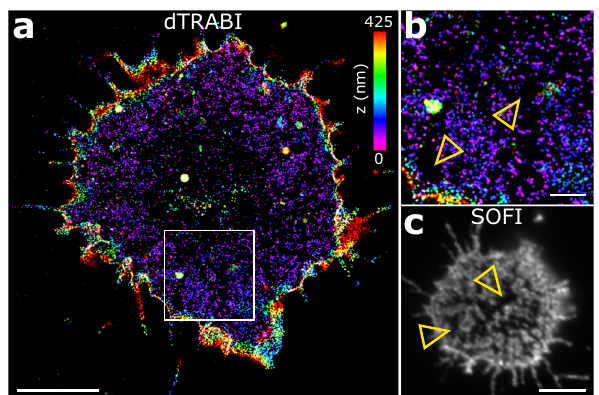
Fig. 6 CD45 exclusion zones on the surface of resting Jurkat cells. a Three-dimensional dTRABI image of CD45 (labeled with antibody as in Fig. 4) on Jurkat cell immobilized on a glycine-coated coverslip. b Magni fi ed ROI as in a with indicated areas lacking CD45 localizations (yellow arrowheads). c 2D SOFI image of CD45 on Jurkat cell immobilized on a glycine-coated coverslip. CD45 was labeled using Alexa Fluor 647- conjugated MEM-28 antibody. Yellow arrowheads indicate cell surface areas lacking CD45 signal. Scale bars, a 5 µ m, b 1 µ m and c 5 µ